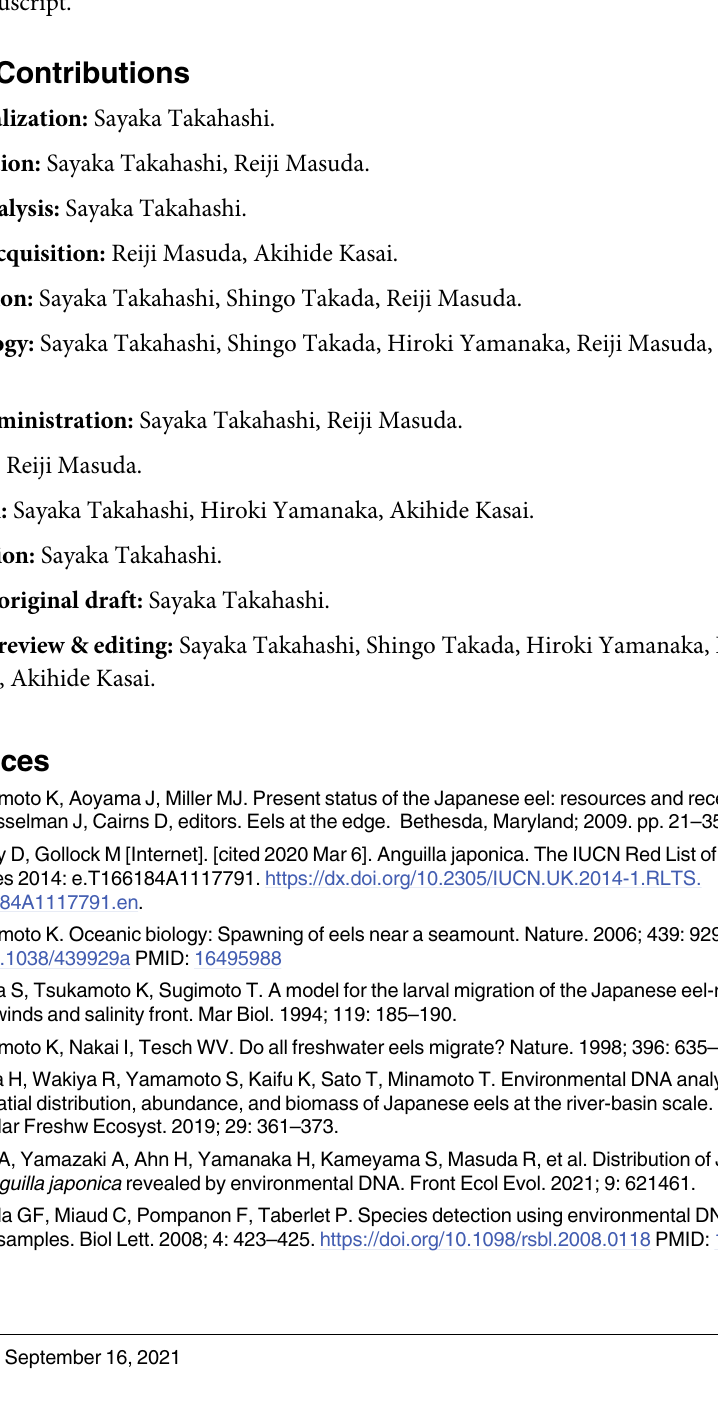
S8 Table. Activity score used in Figs 3 and 4 and S1 Fig.